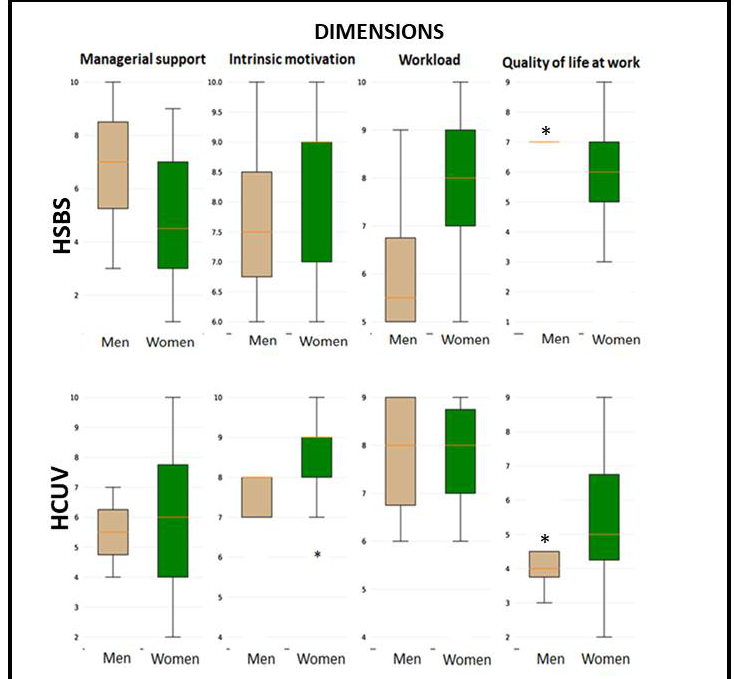
Figure 1. Overall median score for each dimension of the CVP-35 questionnaire in nursing staff in both hospitals (HSBS and HCUV), separated by gender. The 95% confidence interval of the median, calculated by bootstrap, is shown. * Indicates significant differences between median values for men and women, (Krustall-Wallis p < 0.05).